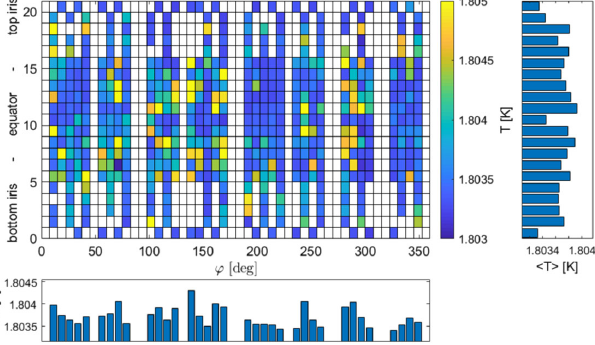
FIG. 11. Relative heating for applied field in φ ¼ 90 °, α ¼ 0 °. ¼ 2 . 7 × 10 10 . It is indicated where the magnetic field is perpendicular to 0 the cavity ’ s surface. The data is recorded at 1.8 K, and E ¼ 15 MW = m. The quality factor is Q acc